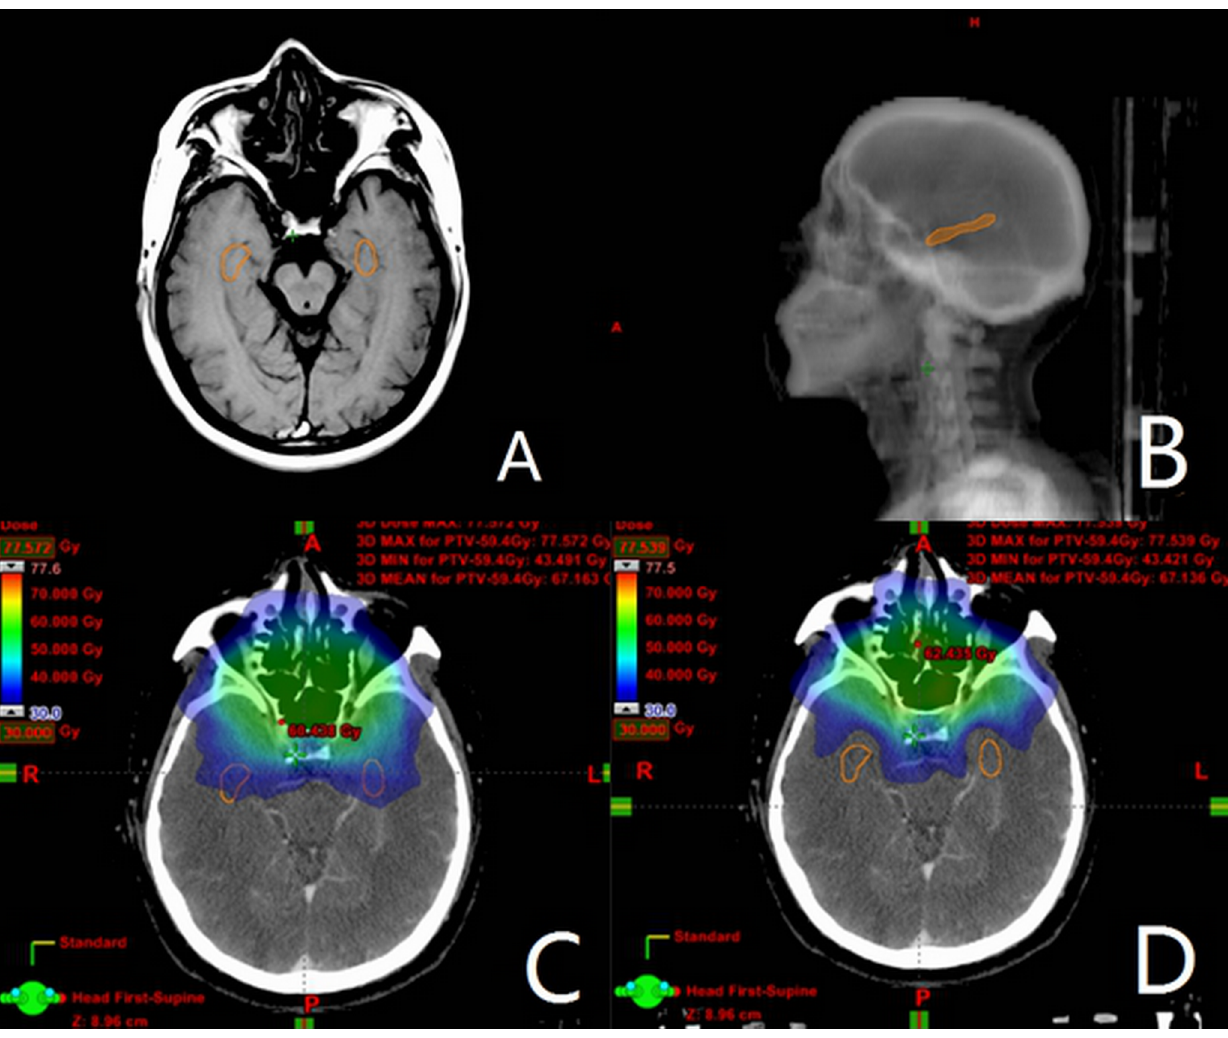
Figure 1. View of dose distribution of the hippocampus contoured on CT-MRI fusion. (A) The hippocampus was contoured on axial T1- weighted MRI. (B) Sagittal DRR image showing hippocampus. (C) Non-HPC sparing IMRT plan. (D) HPC sparing IMRT plan. Orange contour = hippocampus. Green dose cloud =60 Gy. Light green dose cloud =50 Gy. Sky-blue dose cloud =40 Gy.